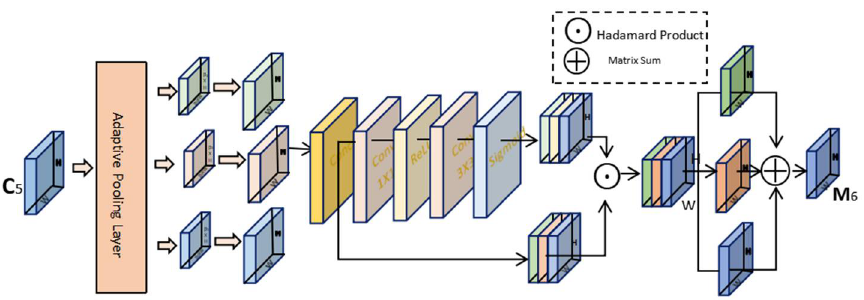
Figure 5. The structure of the AAM [22].